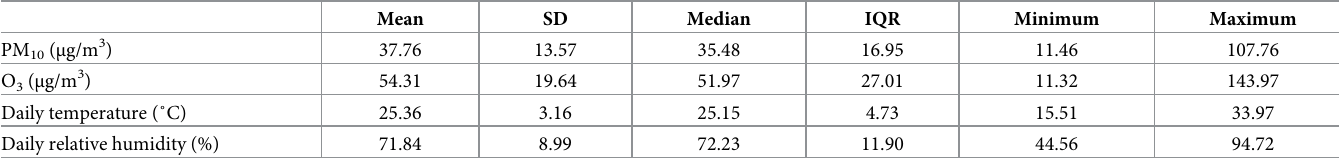
Table 1. Summary statistics of pollutant concentrations and meteorological variables in Rio de Janeiro, Brazil (2012–2017).